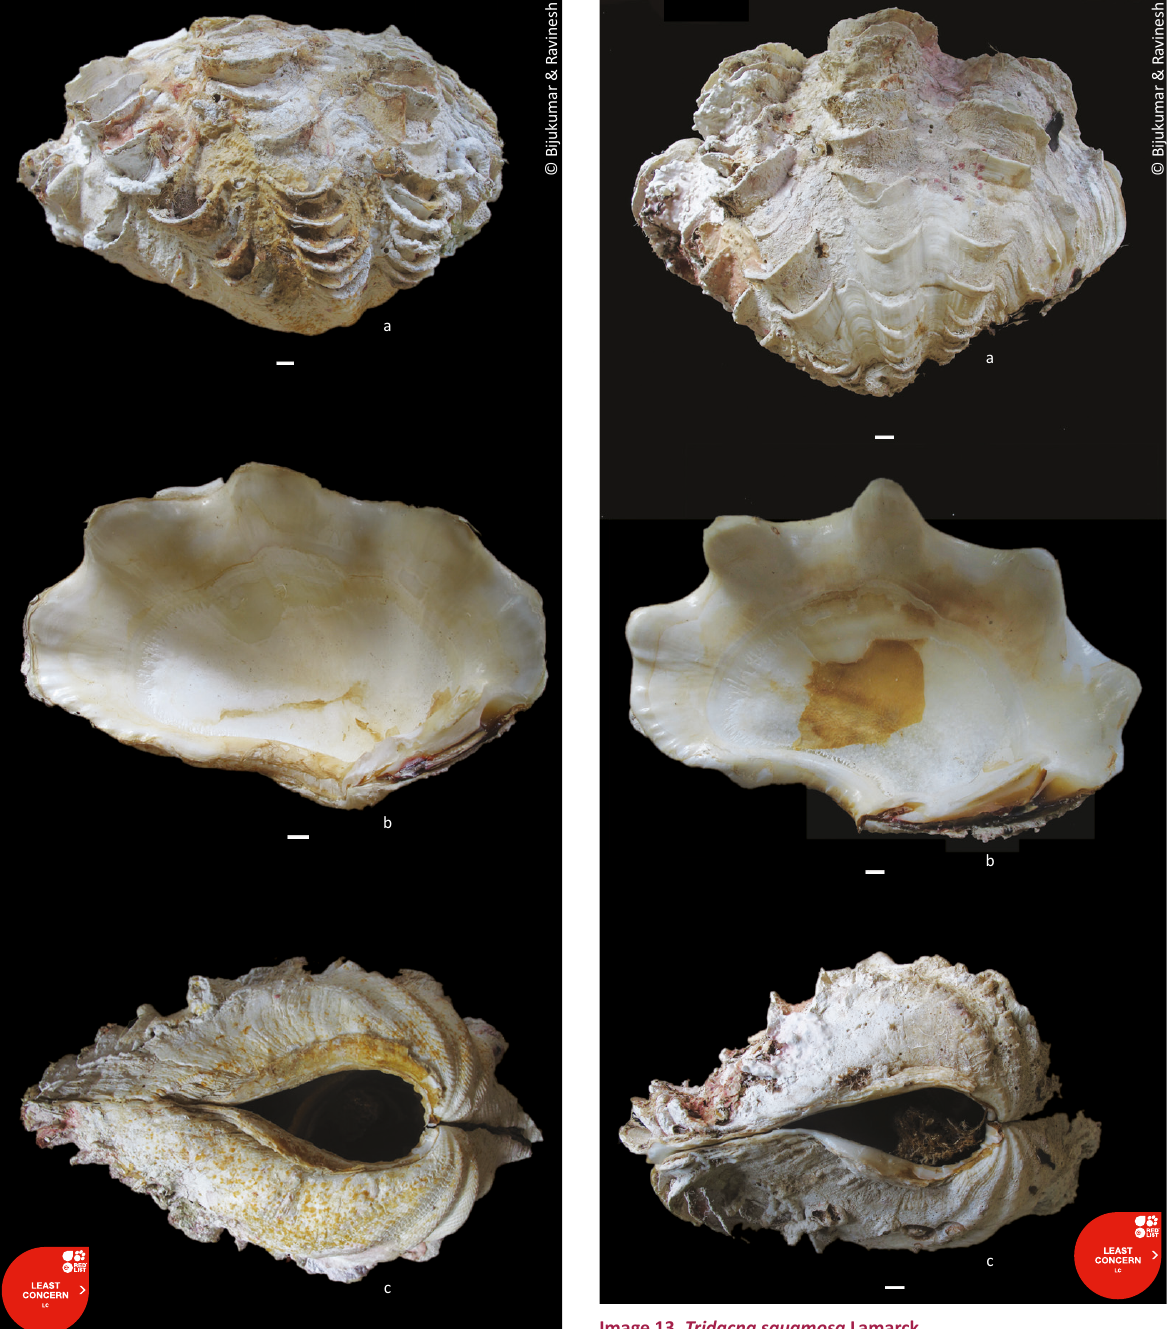
Image 13. Tridacna squamosa Lamarck a - exterior of right valve; b - interior of left valve; c - ventral view showing byssal orifice (scale =